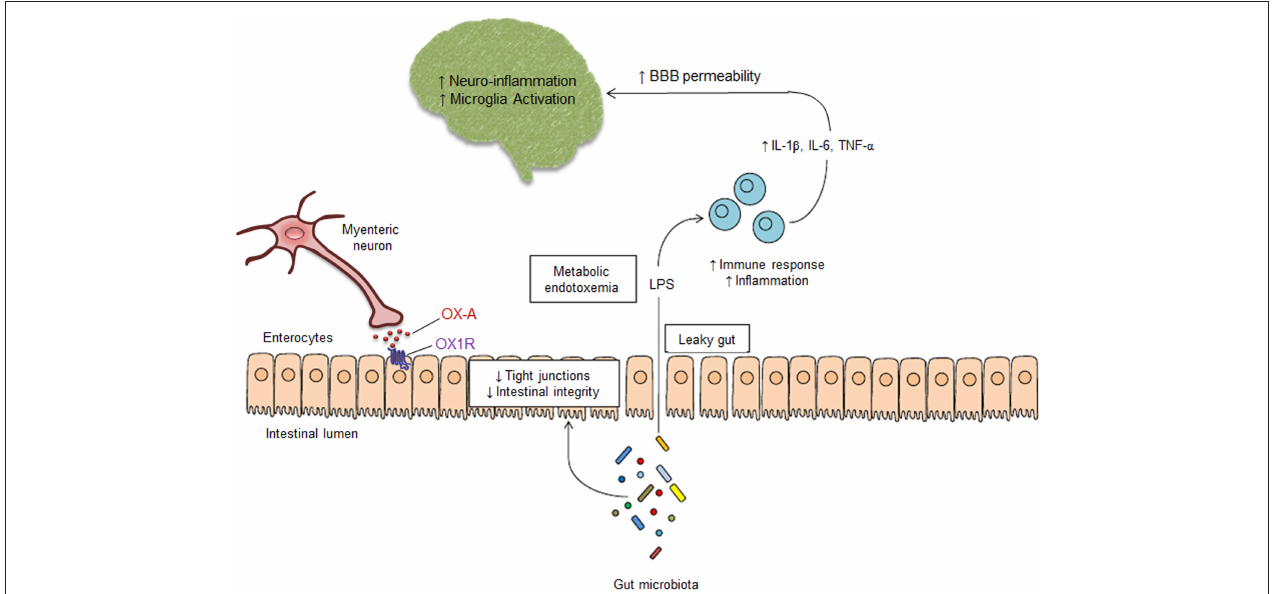
FIGURE 5 | Schematic mechanism of peripheral OX-A-mediated neuroprotection. Alterations of gut microbiota cause the increase of IEB permeability, leading to LPS leaking into the systemic circulation. OX-A released by myenteric neurons, by interacting with OX-1R expressed on the basolateral side of enterocytes, prevents the decrease of occludin expression by the tight junction complex in the intestinal epithelium, thereby preventing intestinal barrier impairment induced by LPS. OX-A blocks the LPS translocation to the blood, thus preventing the metabolic endotoxemia, the activation of immune cells and the subsequent systemic and central inflammation, which are responsible of blood brain barrier impairment and microglia activation. Therefore, peripheral OX-A can act as an epithelial barrier protective factor that may prevent LPS translocation from the gut lumen to the CNS and, consequently,